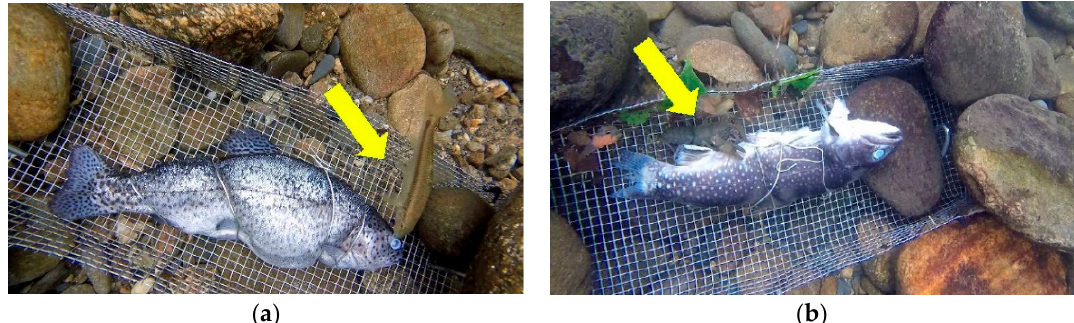
Figure 1. Images captured during hour-long GoPro™ video events showing ( a ) Rainbow trout ( Oncorhynchus mykiss ) scavenged by Nocomis micropogon and ( b ) Brook trout ( Salvelinus fontinalis ) carcass visited by crayfish. Scavenger species are indicated by a yellow arrow.